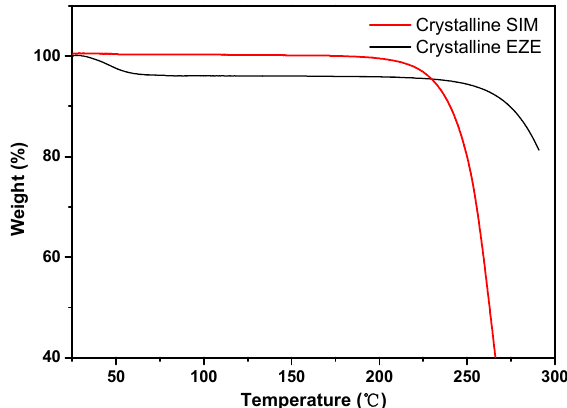
Figure 1. The TGA traces of crystalline EZE and SIM. Figure 2 presents the DSC traces of crystalline EZE, SIM, and their 1:1 molar ratio